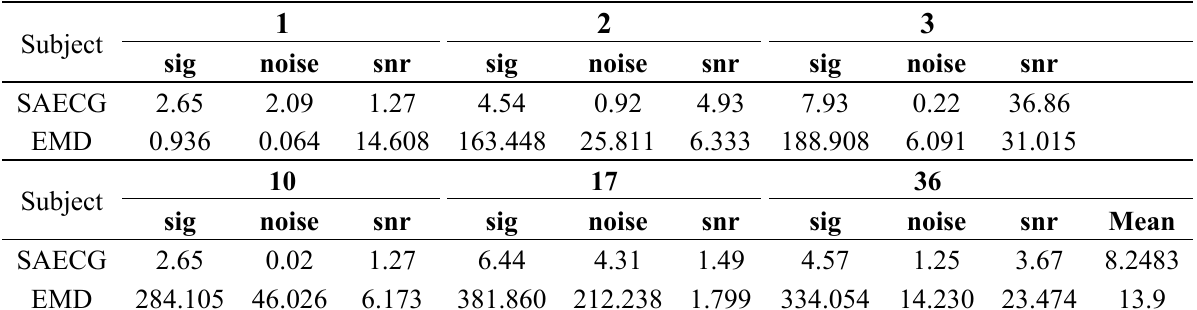
Table 1. SNR of signal averaged electrocardiogram (SAECG) compared to empirical mode decomposition